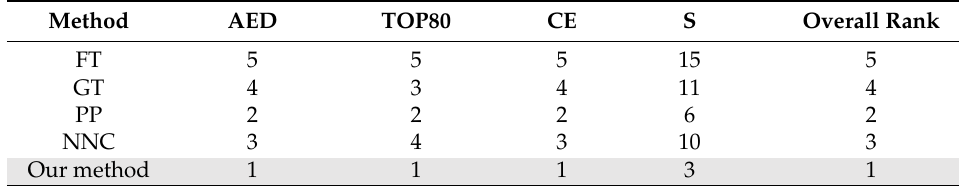
Table 5. Overall ranking on PubLayNet